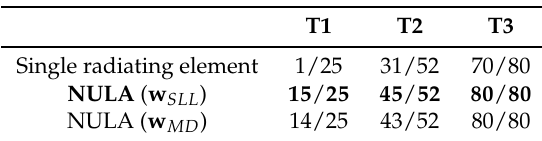
Table 11. Number of detections with respect to the number of Coherent Processing Intervals (CPIs) associated with the considered trajectories.